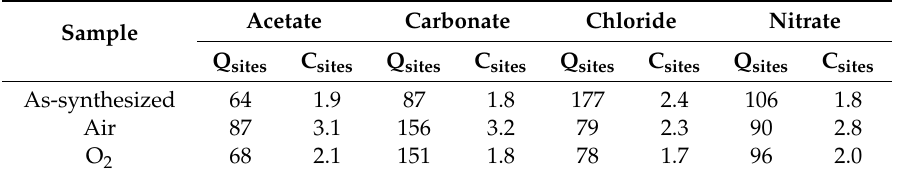
Figure 8. CO adsorption followed by FT–IR over as-synthesized MgF 2 prepared from acetate, carbonate, chloride and nitrate magnesium precursors after the HF activation step. Table 5. CO adsorption followed by IR of MgF 2 samples after HF activation. Impacts of the magnesium precursors and of the calcination atmosphere (air and O 2 ) on the number of acid sites (Q sites : µ mol · g − 1 ) and their concentration (C sites : µ mol · m − 2 ). Estimated relative uncertainty: 5%.